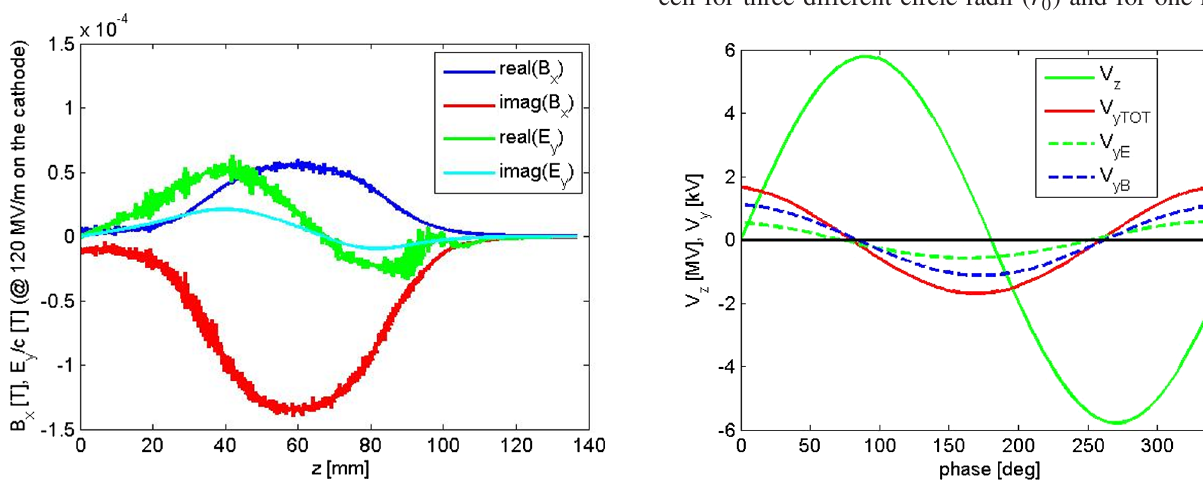
FIG. 31. Transverse magnetic and electric field components on axis.